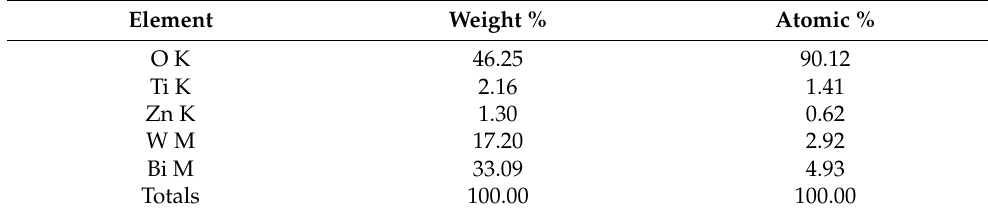
Table 1. The content of various elements in the Bi 2 WO 6 /ZnTiO 3 sample according to EDX. Element Weight %